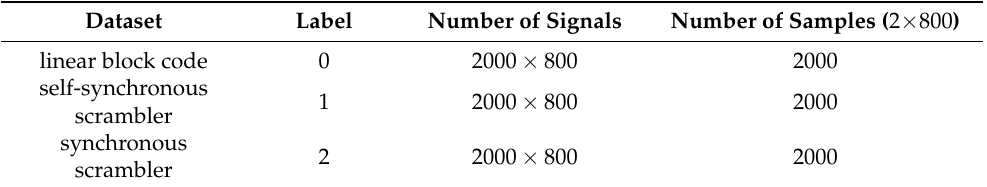
Table 2. Linear block code scrambling dataset with noise.